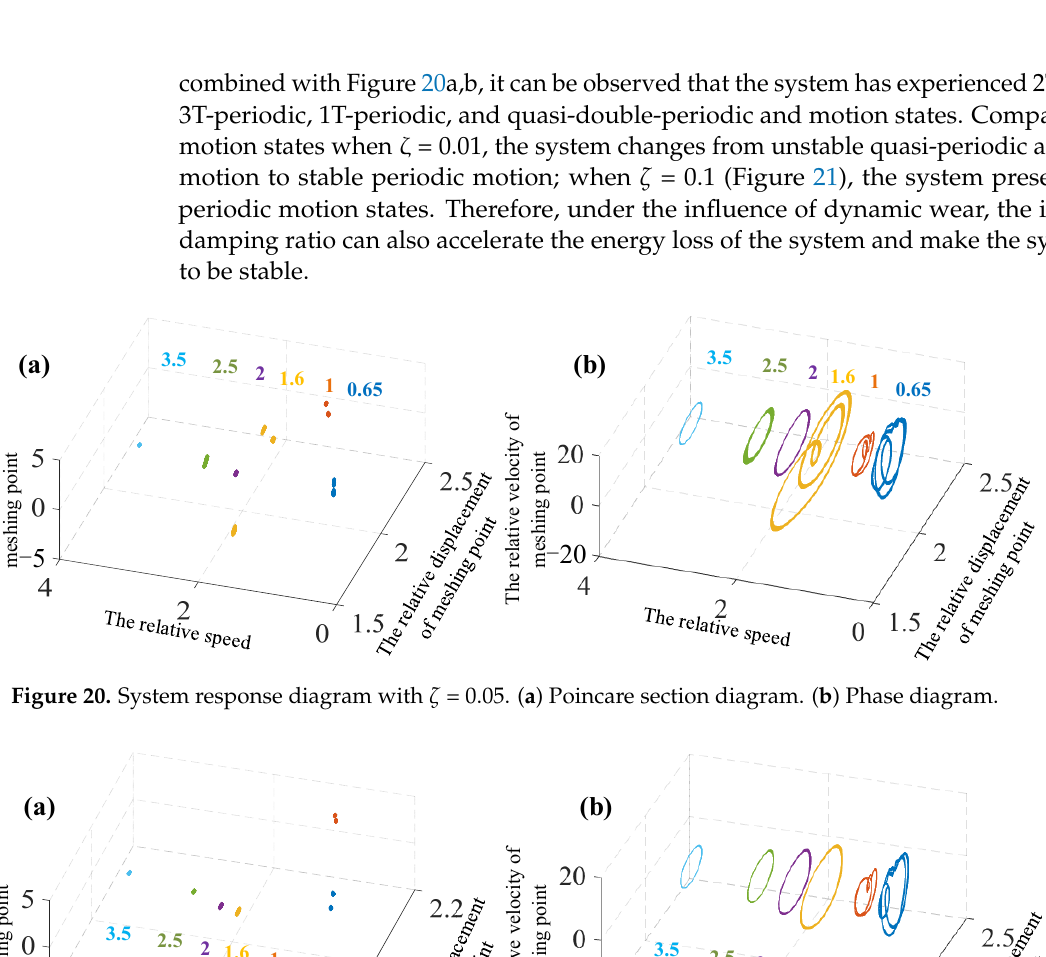
Figure 21. System response diagram with ζ = 0.1. ( a ) Poincare section diagram. ( b ) Phase diagram. Due to different coordinates of Figures 19–21, the transition of motion states is not obvious. The system with relative speed ω = 2.5 is taken for analysis, and the Poincare section diagrams with ζ = 0.01, 0.05 and 0.1 are obtained, as shown in Figure 22. Then, it can be observed that the system gradually changes from quasi four periodic to single periodic, and the system tends to be stable.